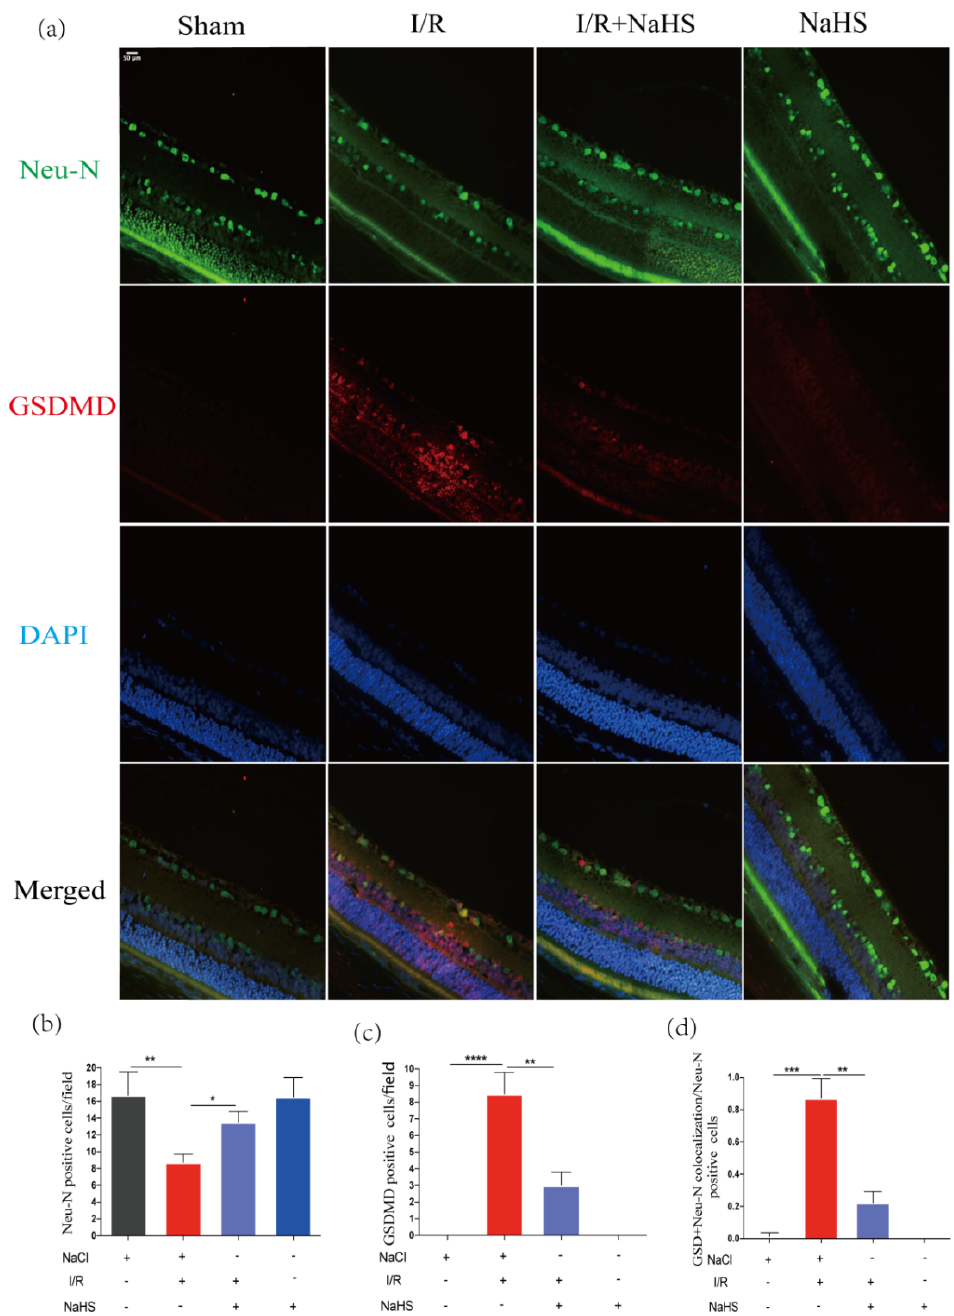
Figure 6. NaHS inhibited neuron pyroptosis in the rat retina after I/R. ( a ) Immunofluorescence staining of Neu-N and GSDMD of in retinal GCL region. Scale bar = 50 µ m. ( b ) Analysis of Neu-N Positive cells in the retinal GCL region ( n = 3). ( c ) Analysis of GSDMD-positive cells in the retina GCL region ( n = 3). ( d ) Analysis of the ratio of the Neu-N and GSDMD double-positive cells to the Neu-N + cells in the retina GCL region ( n = 4). Data are represented as means ± SD. * p < 0.05, ** p < 0.01, *** p < 0.001, **** p < 0.0001.